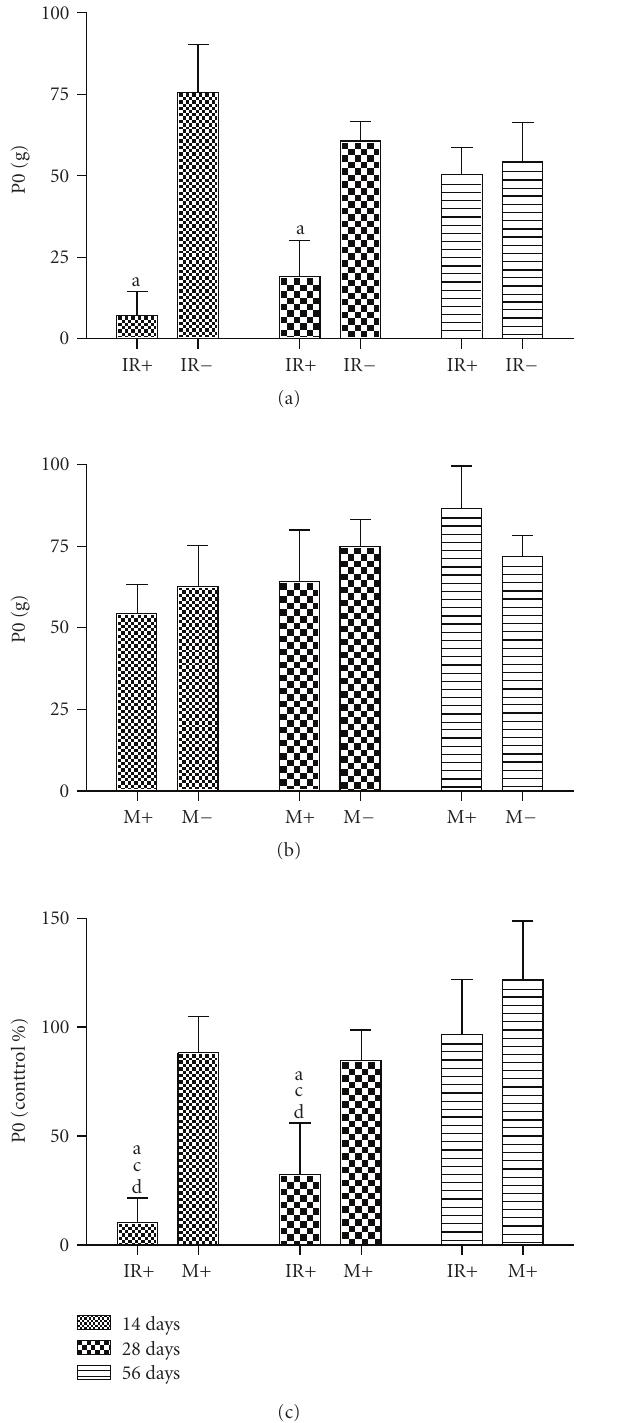
Figure 3: Specific maximal tetanic force (P 0 / m) of muscles after ischemia-reperfusion injury and myotoxin injury. Val- ues are means ± SEM. Number of data per group is 4– 6. IR+: ischaemic/reperfused muscles, IR − : control muscles of ischaemic/reperfused muscles, M+: myotoxin-treated muscles, M − : control muscles of myotoxin-treated muscles. (a) significantly di ff erent from control ( P < . 05), (b) significantly di ff erent from 28 days ( P < . 05), (c) significantly di ff erent from 56 days ( P < . 05), (d) significantly di ff erent from